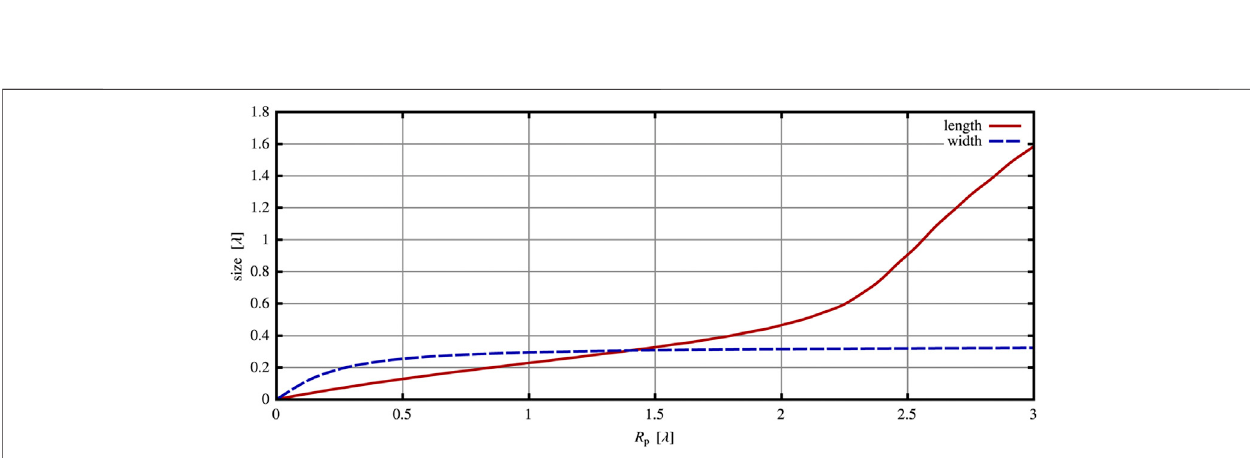
Frontiers in Physics |